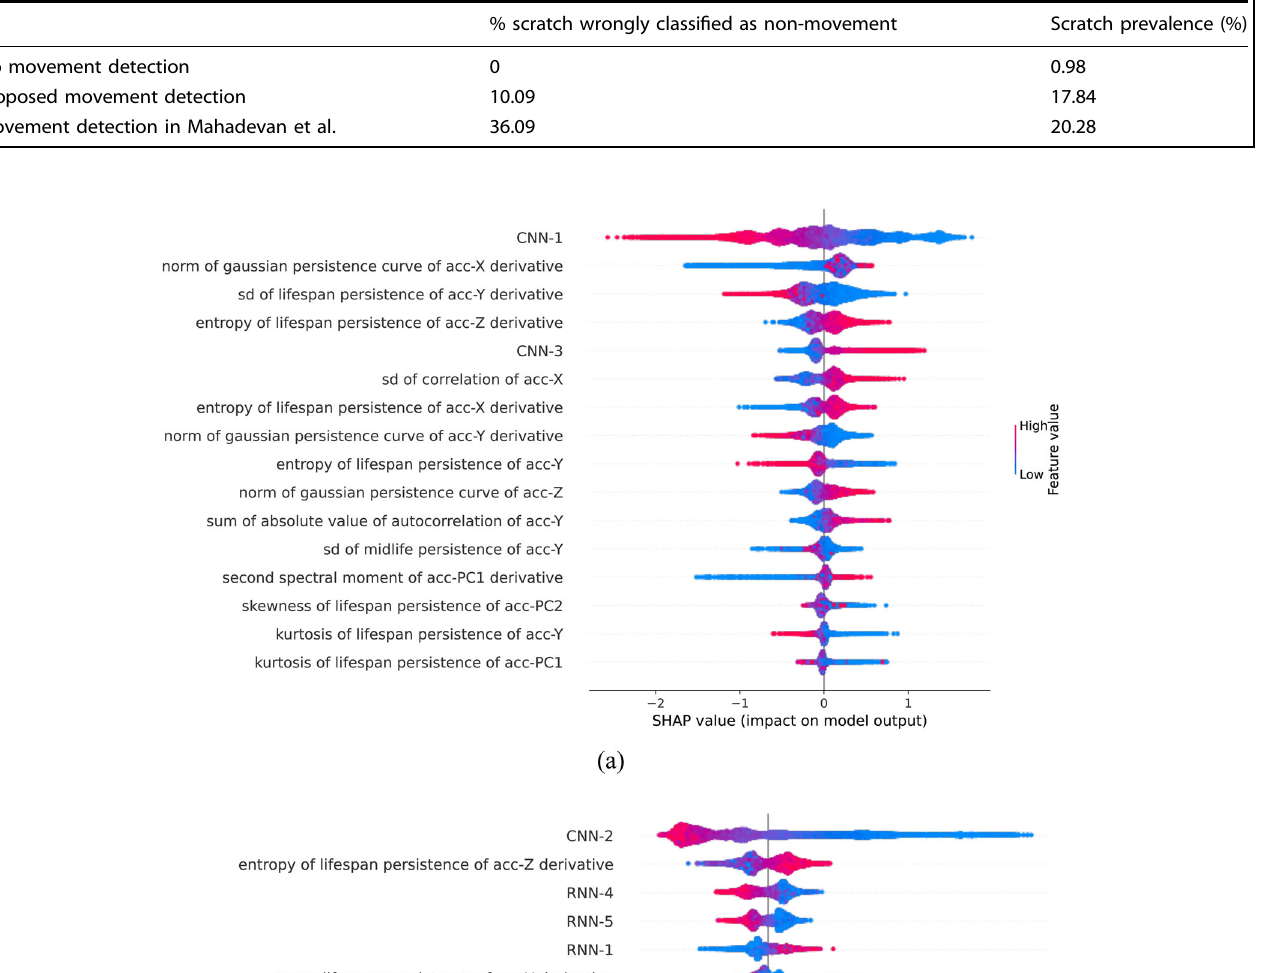
Table 2. Performance of movement detection algorithm.